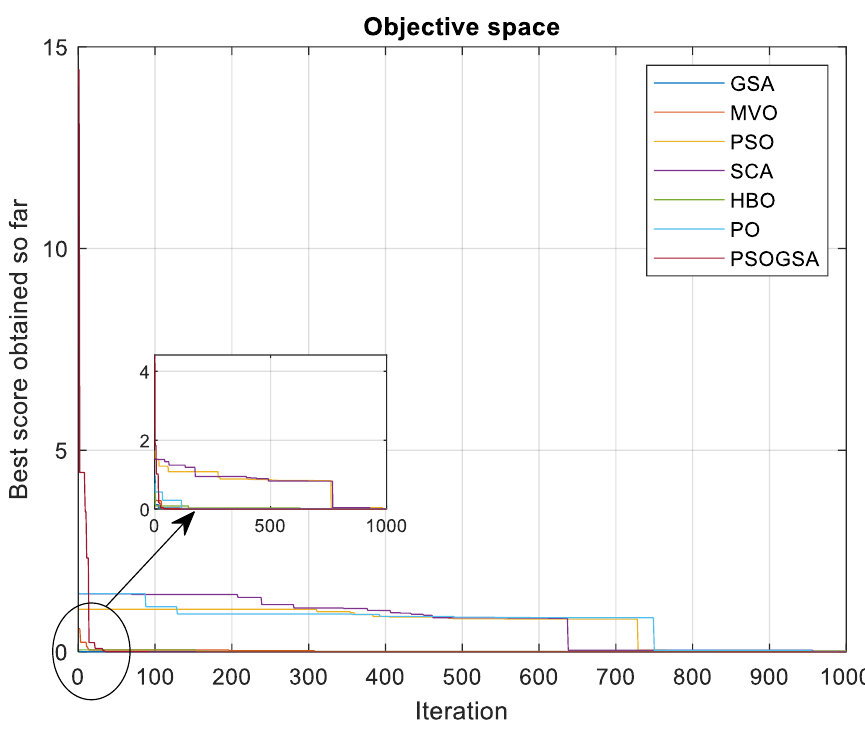
Figure 13. The convergence curve of the polycrystalline MTDM. Table 17. The MTDM calculation error, mean and standard deviation for Case 2 . Algorithms